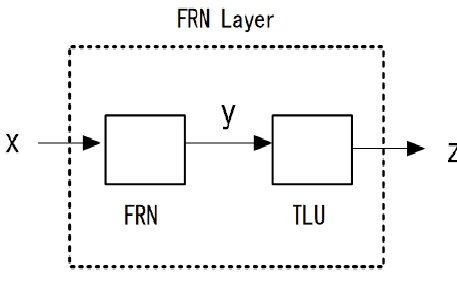
Figure 12. FRN layer structure.